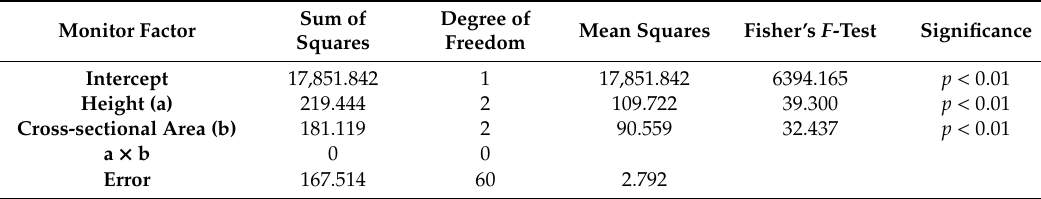
Table 2. The ANOVA of proportional limit stresses of beech.